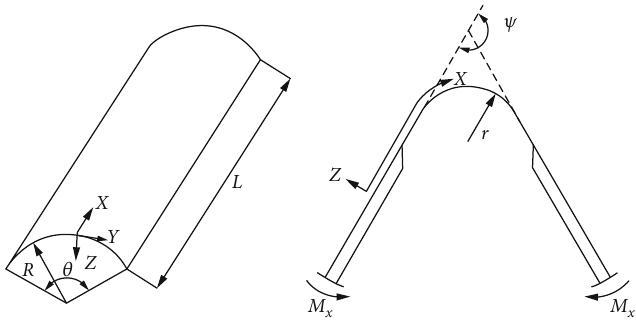
Figure 3: The curvature changes during the shell